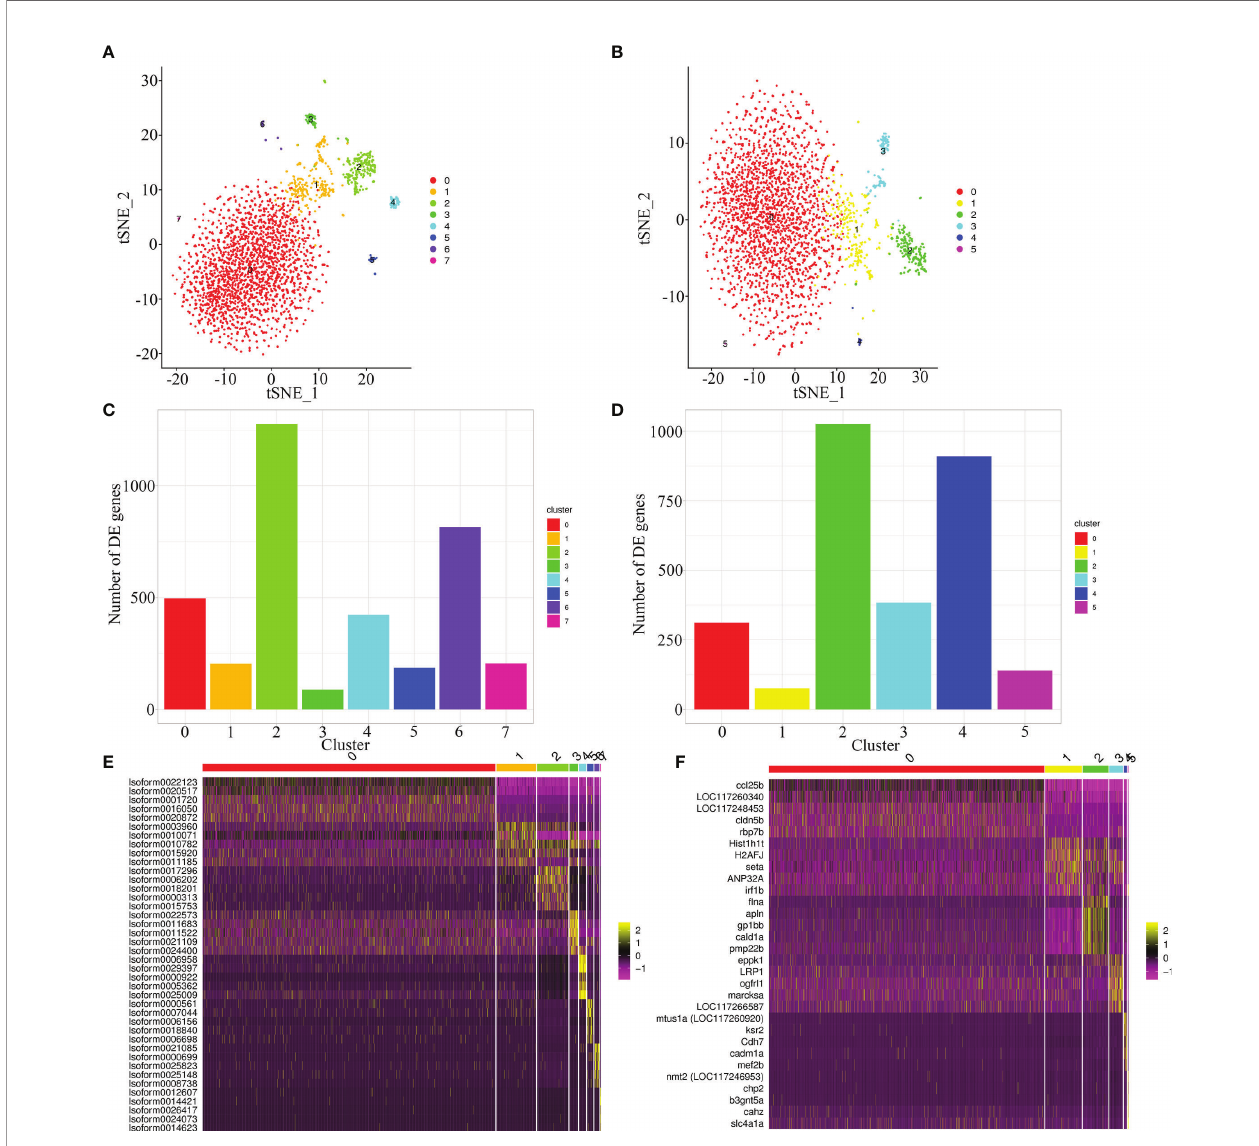
FIGURE 6 | Cell sorting based on full-length transcriptome and E . lanceolatus genome. (A, B) The tSNE nonlinear clustering was used to visualize the classi fi cation results of E . coioides spleen cell populations based on full-length transcriptome (A) and the whole E. lanceolatus genome (B) . (C, D) Statistical histogram of the number of up-regulated genes in each sub-cluster based on full-length transcriptome (C) and E. lanceolatus genome (D) . (E, F) Heatmap of the top 5 up-regulated expression genes from each cluster as a marker gene based on full-length transcriptome (E) and E. lanceolatus genome (F) . Each column in the fi gure represents a cell, and each row represents a gene. The expression levels of genes in different cells are indicated by different colors. The more yellow, the higher the expression level, and the more purple, the lower the expression